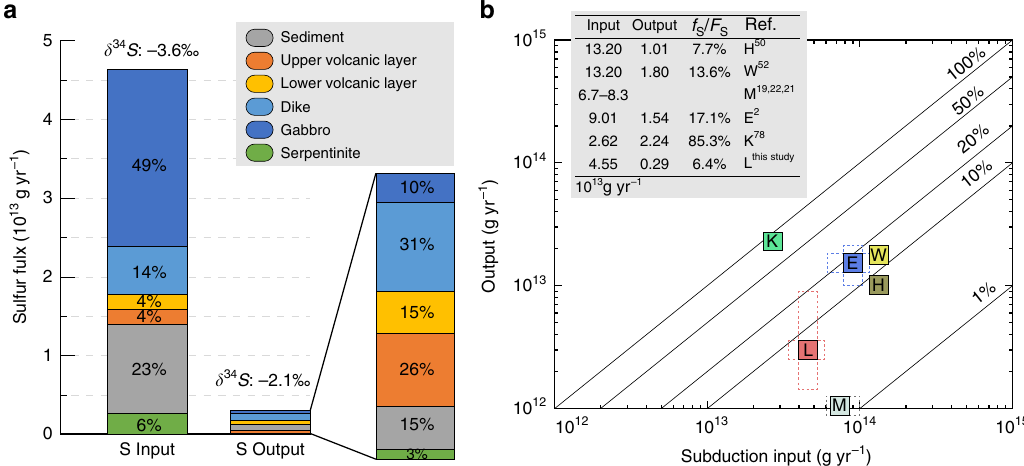
Fig. 8 Mass-balance calculation results of subduction sulfur input and output. a Subduction sulfur input and output (30 – 230 km) categorized by source. b Comparison of subduction sulfur input vs . output. Sulfur in fl ux and out fl ux estimations are given in the inset table. Labeling of estimates refers to source data (see inset), E to Evans 2 ; H to Hilton et al. 50 ; K to Kagoshima et al. 78 ; L to this study; W to Wallace 51 ; and M to Can fi eld 19 , Alt and Shanks 22 , and Alt et al. 21 . Uncertainties of estimates indicated with dashed rectangles. No errors are shown if they were not provided in the original study. Note that there is no output data for